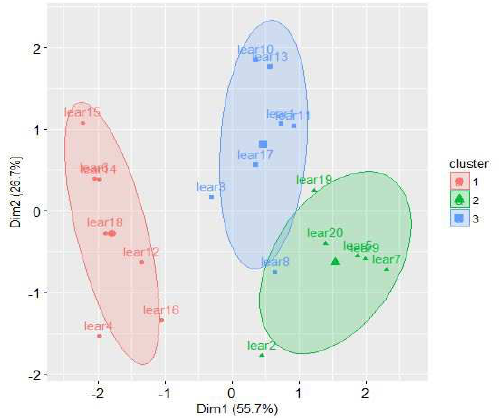
Figure 2. Clustering result with